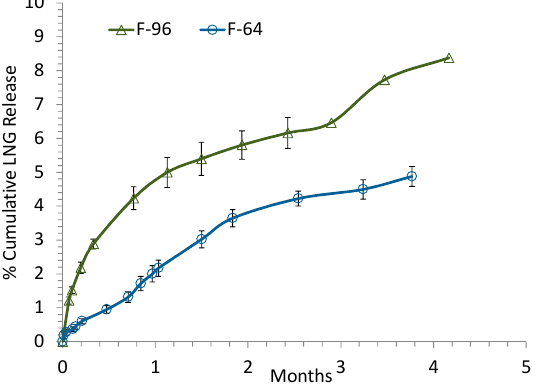
Figure 1. Real-time (long term) in vitro release of LNG from formulations 64 (open circle) and 96 (open triangle) in PBS medium (pH 7.4) at 37 °C.